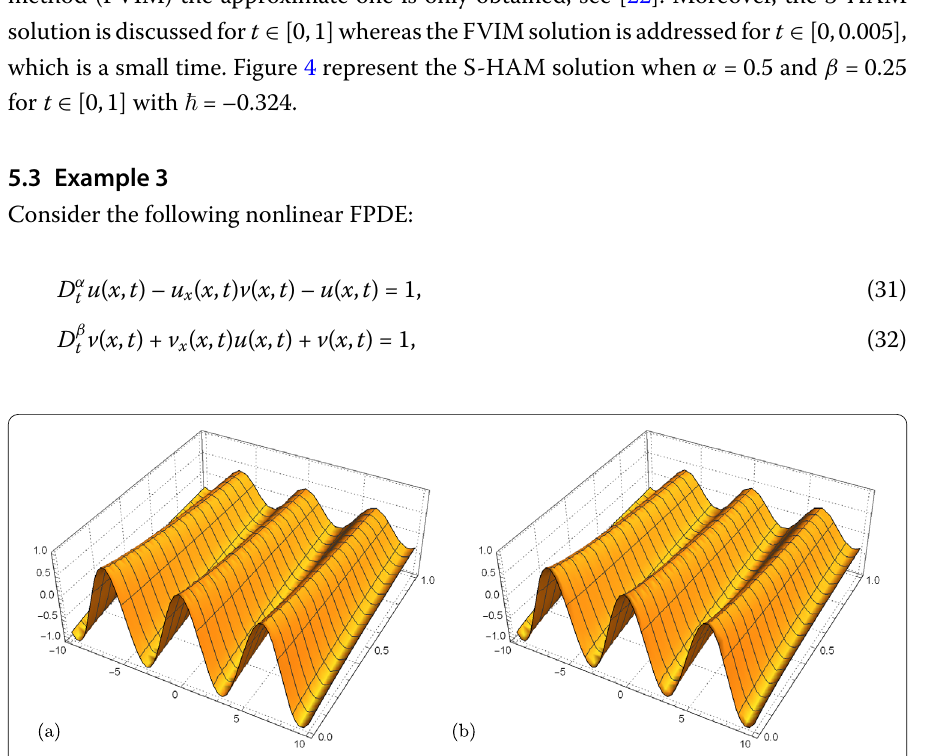
Figure 2 Solution Example 2 using α = 0.9 and β = 0.8. (a) for u ( x , t ) and (b) for v ( x , t